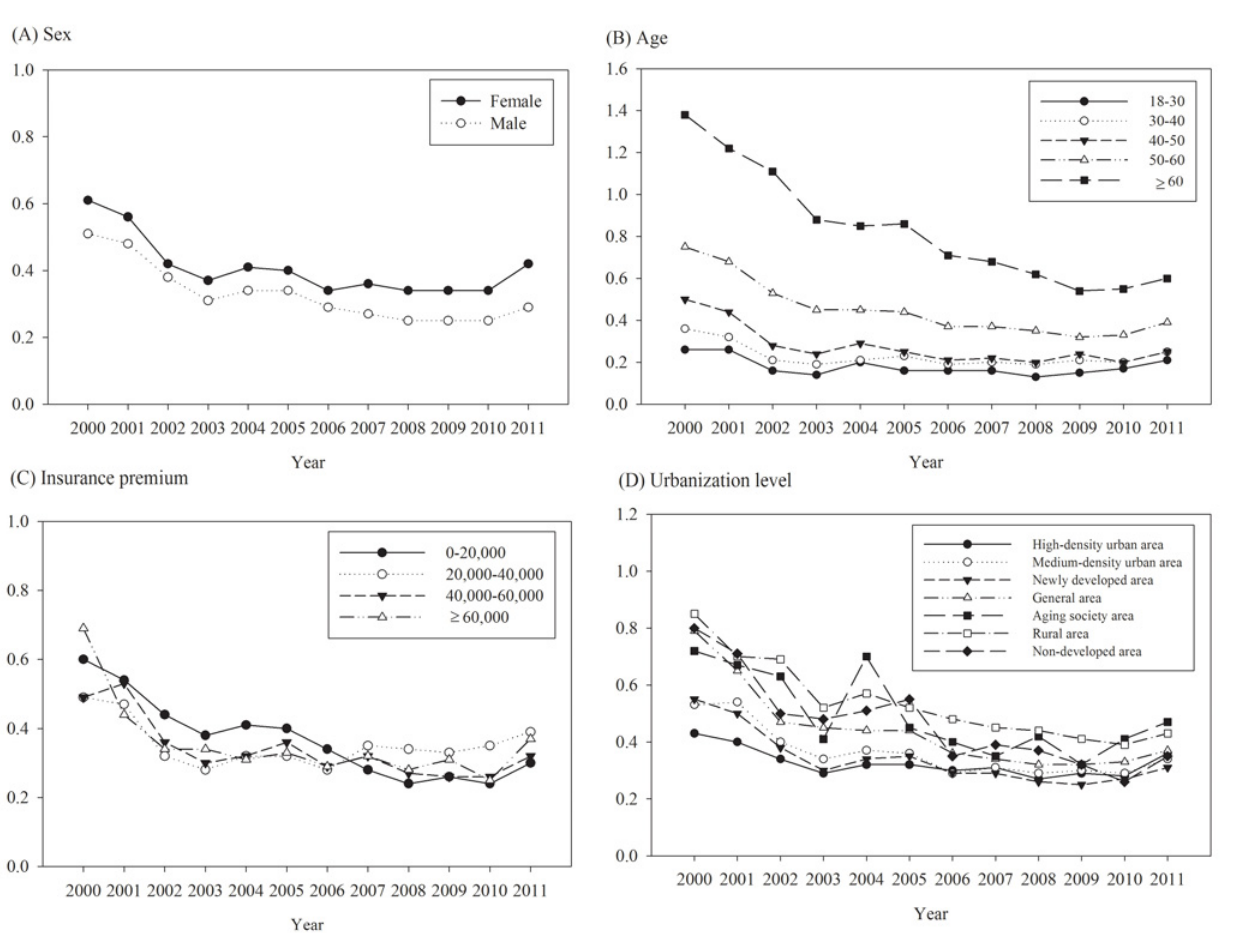
Fig 3. Time trends in the incidence of asthma stratified by (A) sex (B) age (C) insurance premium (D) urbanization level.